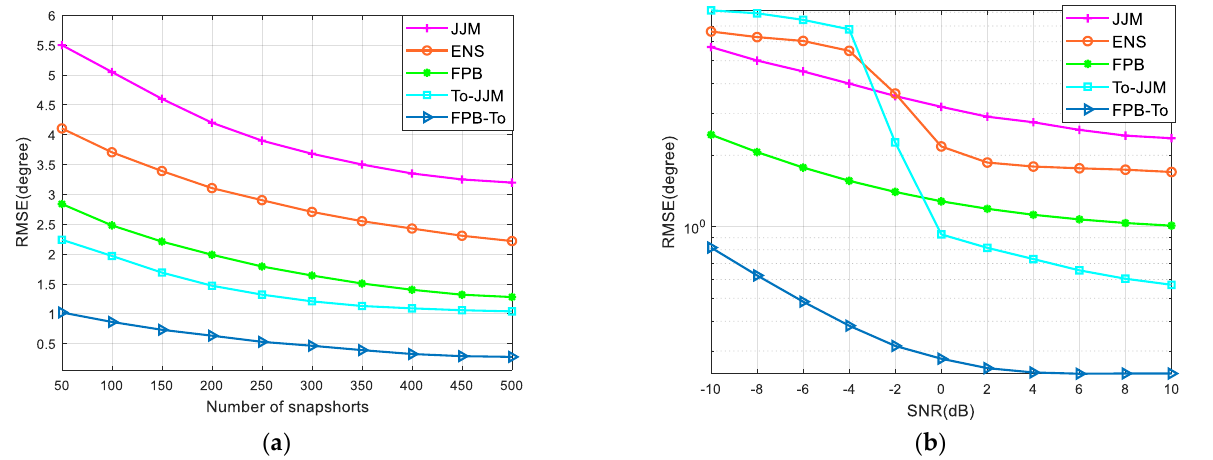
Figure 3. RMSE analysis: ( a ) RMSE in relation to snapshots; ( b ) RMSE in relation to SNR.